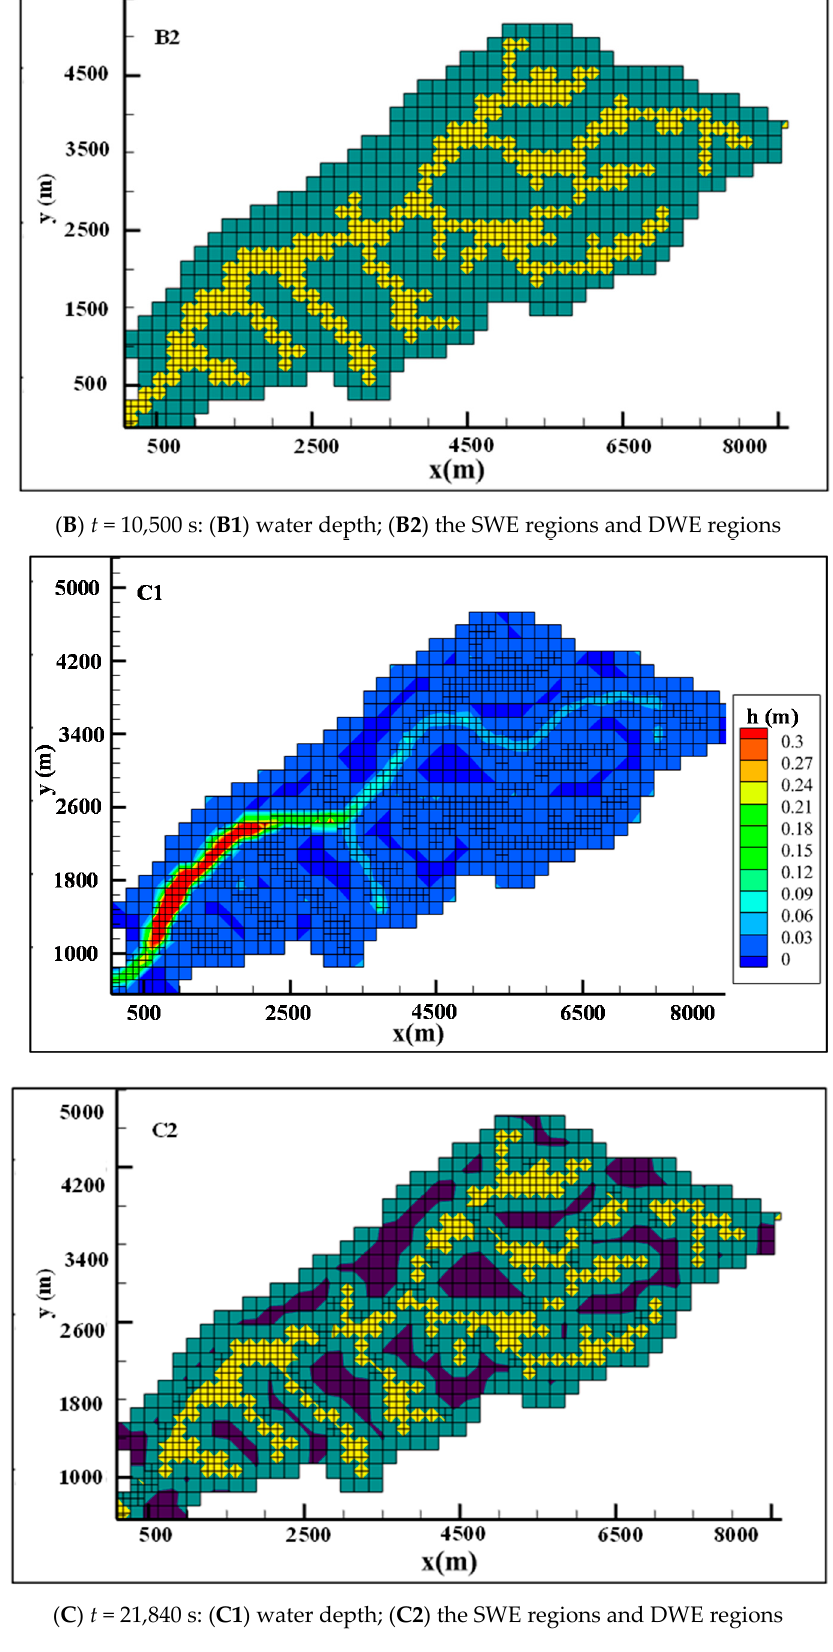
Figure 21. Map of flow depth and position of the coupling boundary at different times.